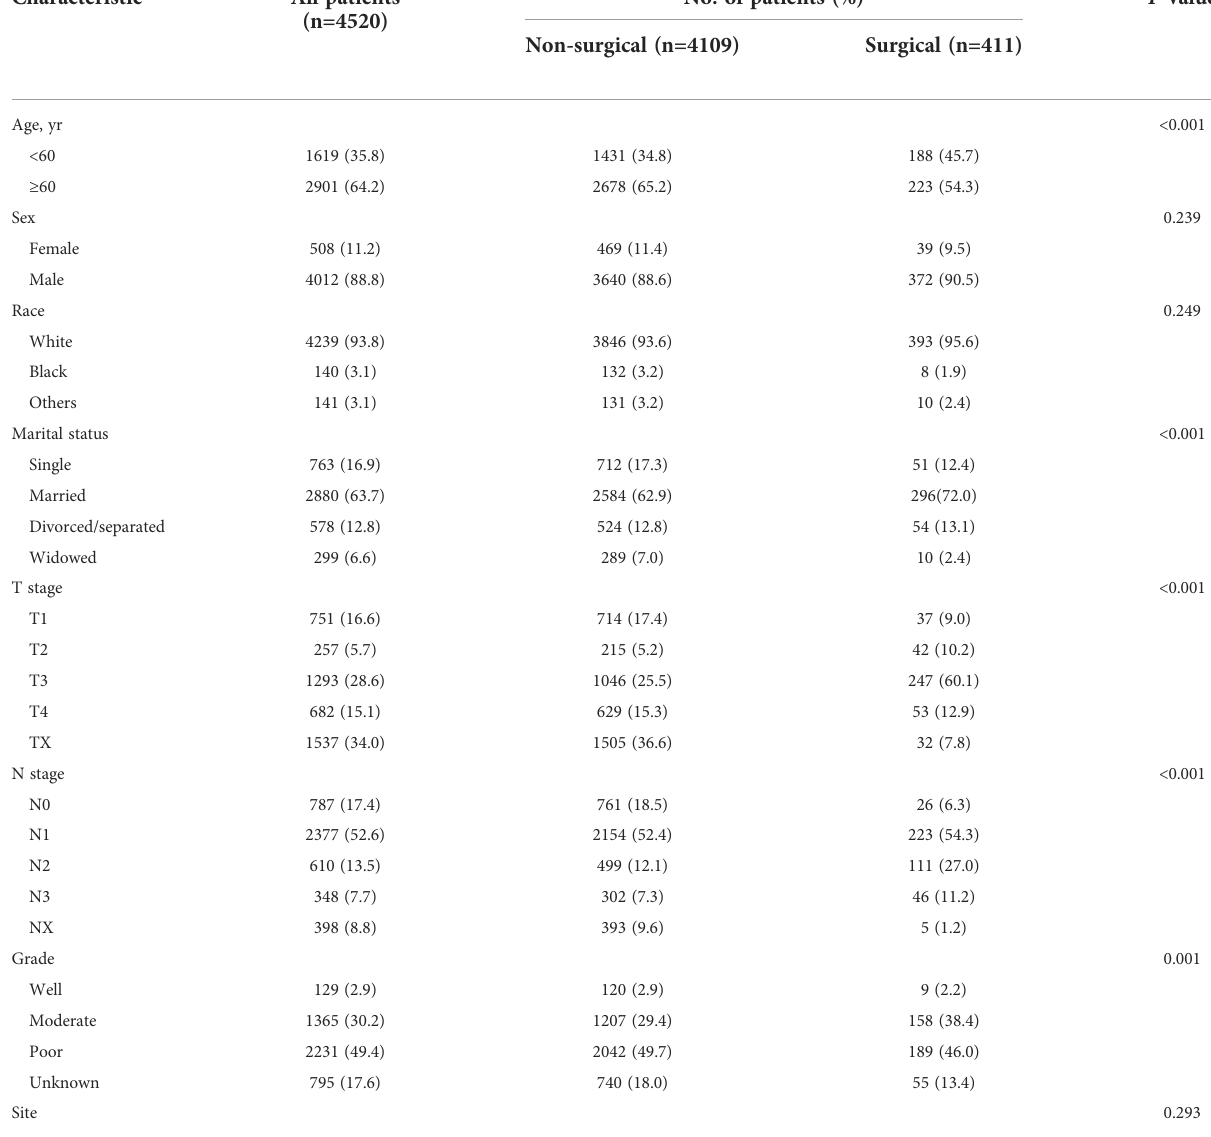
TABLE 1 Patients demographic characteristics and clinicopathological